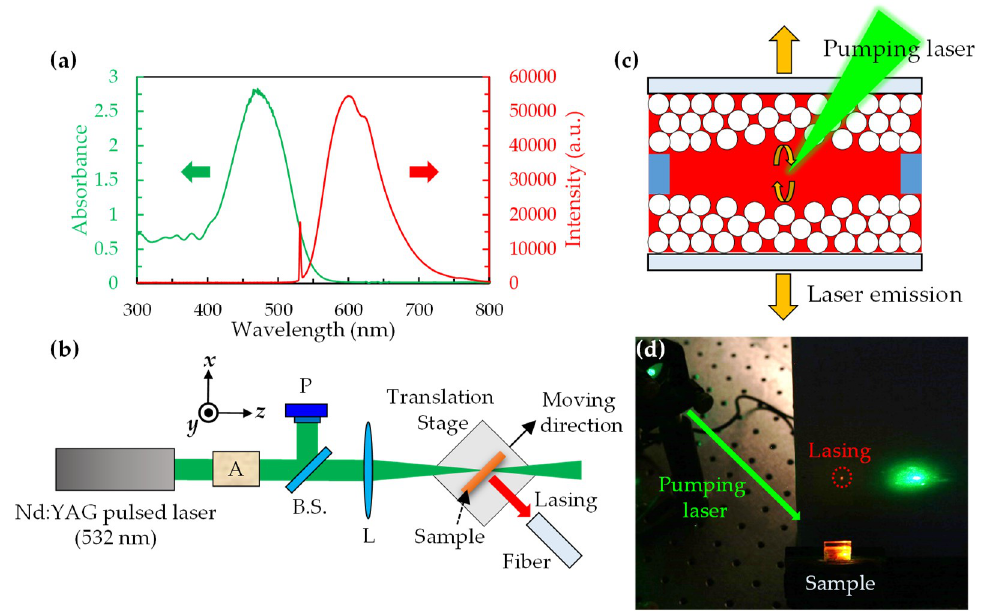
Figure 2. ( a ) Absorption and fluorescence spectra of the DCM-doped NOA 164; ( b ) Experimental setup for measuring the lasing spectrum of the sample at di ff erent irradiating position, where A is the attenuator, P is the power meter, B.S. is the beam splitter, and L is the convex lens, respectively; ( c ) Schematic representation of the laser emission from the CC sample; ( d ) Photograph of the CC laser system.